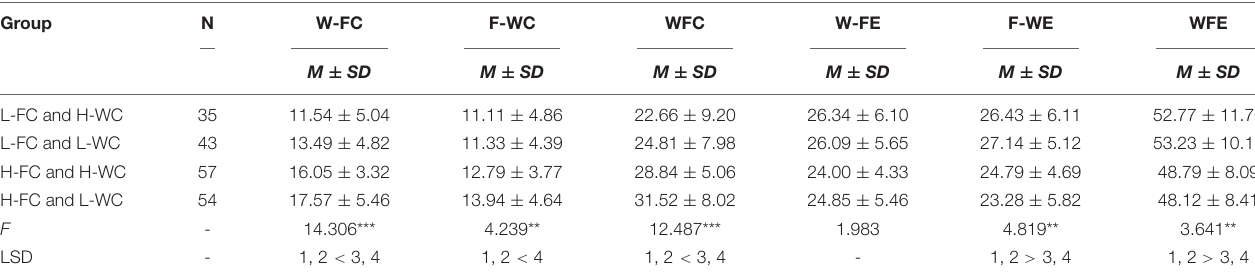
TABLE 4 | Result of one-way